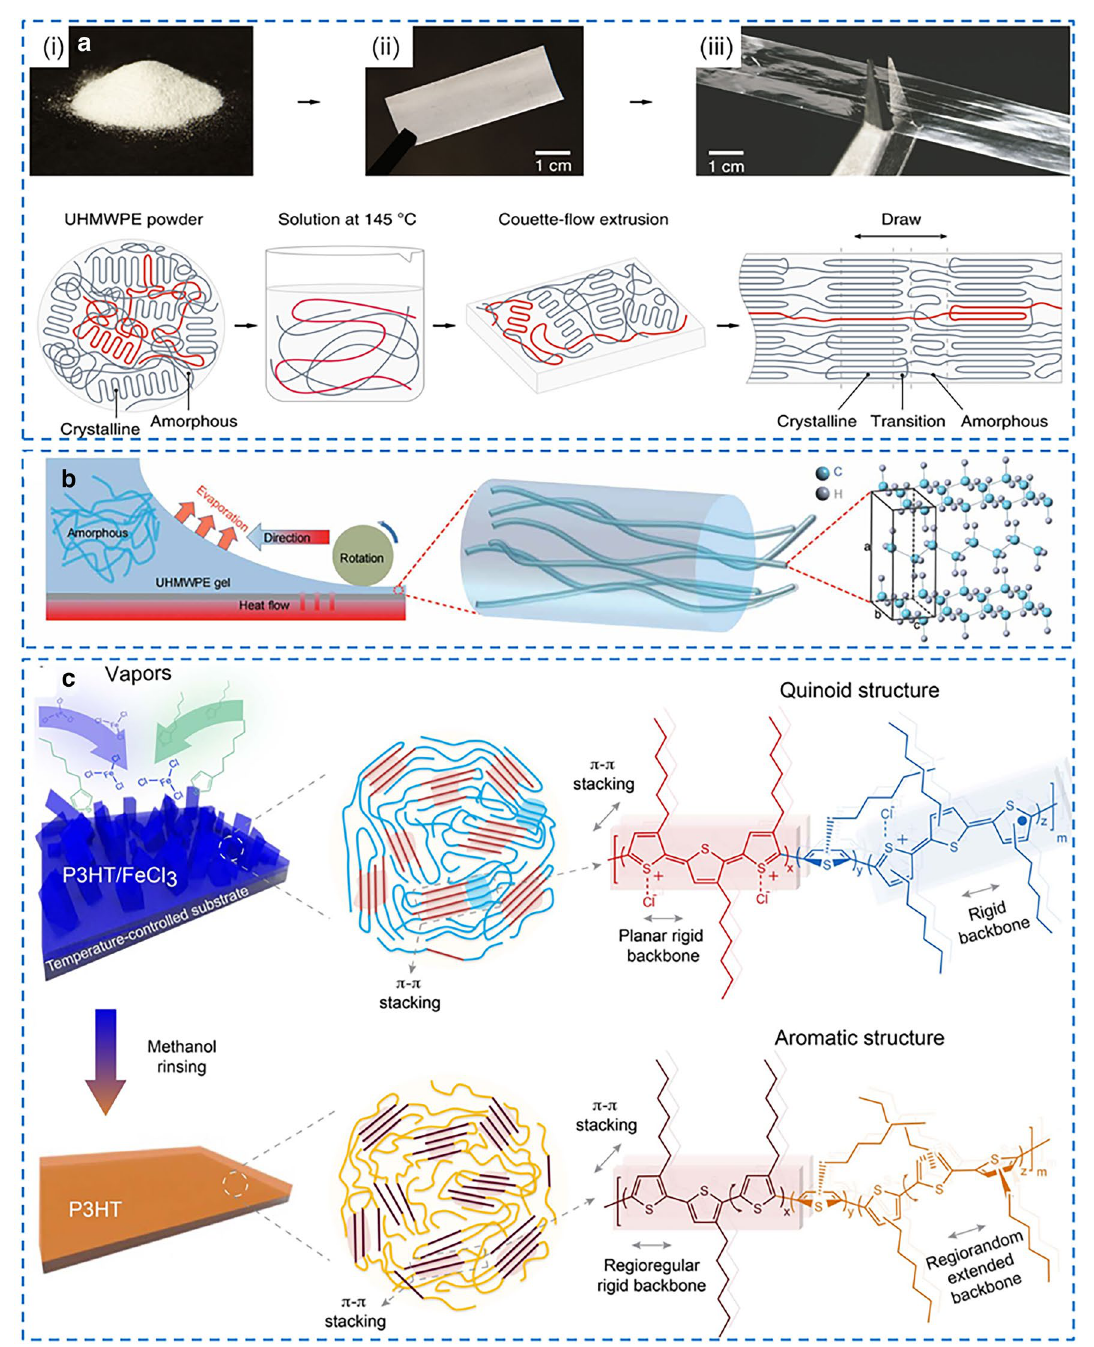
Fig. 6 a Fabrication of UHMWPE films with high intrinsic k via ultradrawing process. Reproduced with permission from Ref. [24]. Copyright 2019, Springer Nature. b Fabrication of UHMWPE films with high intrinsic k via solution gel‑shearing process. Reproduced with permission from Ref. [78]. Copyright 2021, American Association for the Advancement of Science. c Fabrication of conjugated poly(3‑hexylthiophene) films with intrinsic k using oxidative chemical vapor deposition. Reproduced with permission from Ref. [83] Copyright 2018, American Asso‑ ciation for the Advancement of